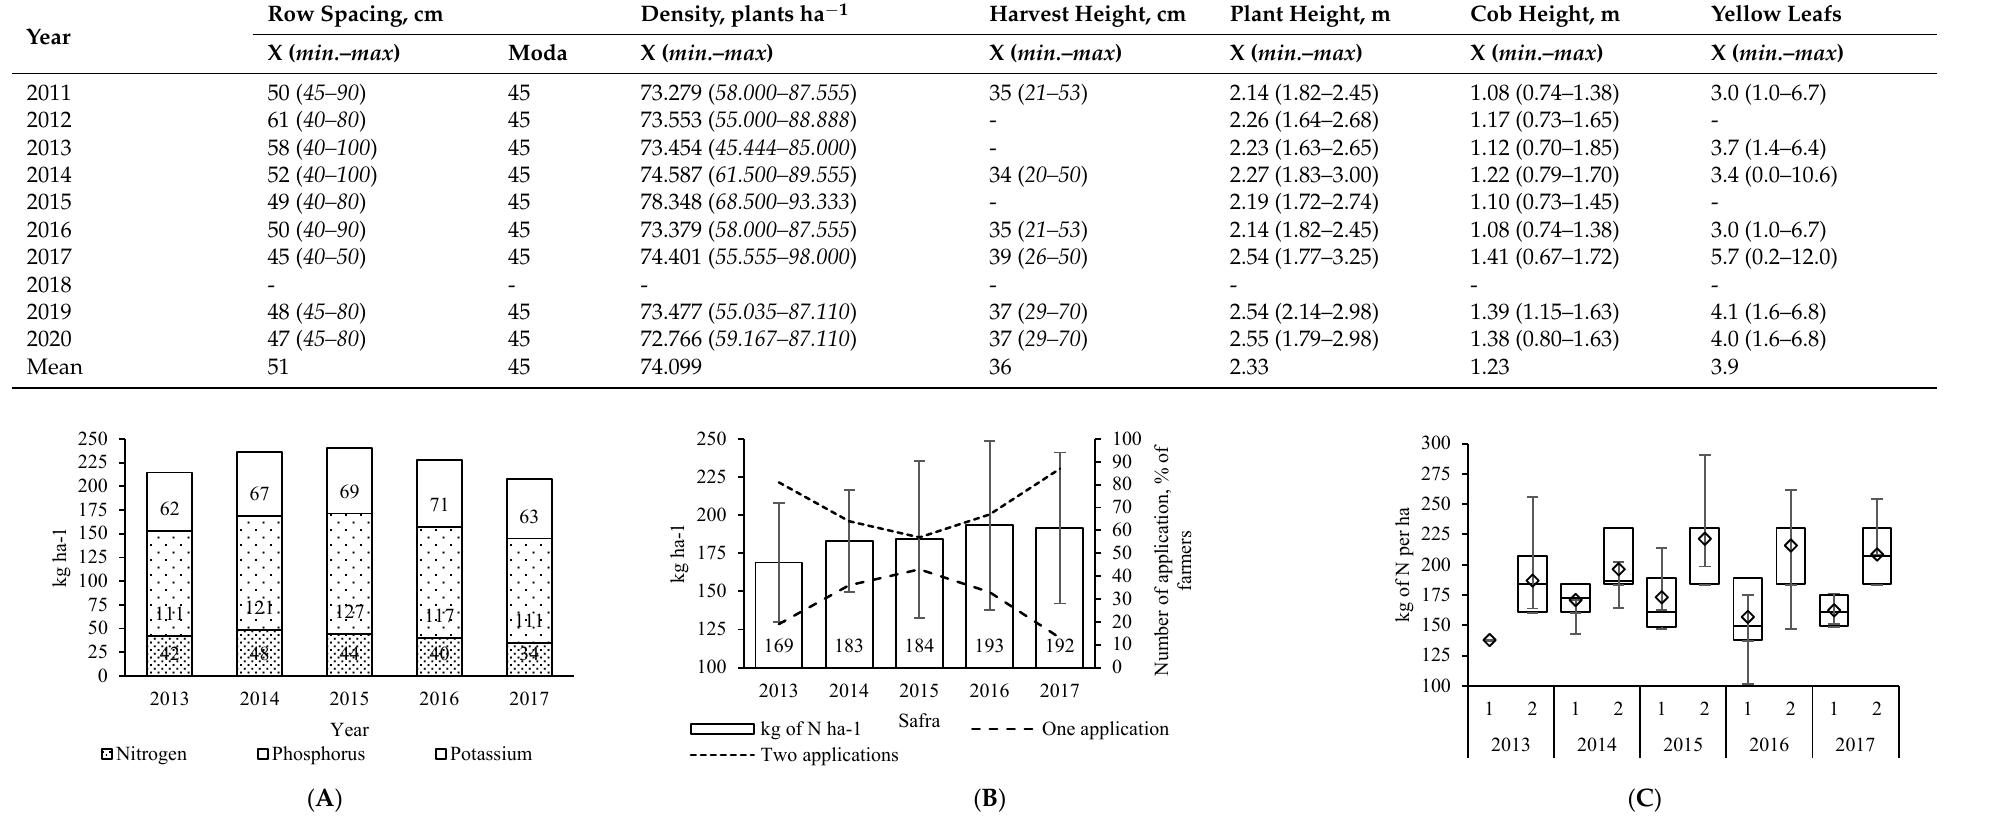
Figure 2. Average fertilization levels of summer crops sampled between 2013 and 2017. ( A ) Baseline fertilization in kilograms of N, P 2 O 5 , and K 2 O per ha. ( B ) Coverage fertilization in kilograms of N per ha (bar) and percentage of producers who made one or two applications (rows). ( C ) Level of N used in one or two